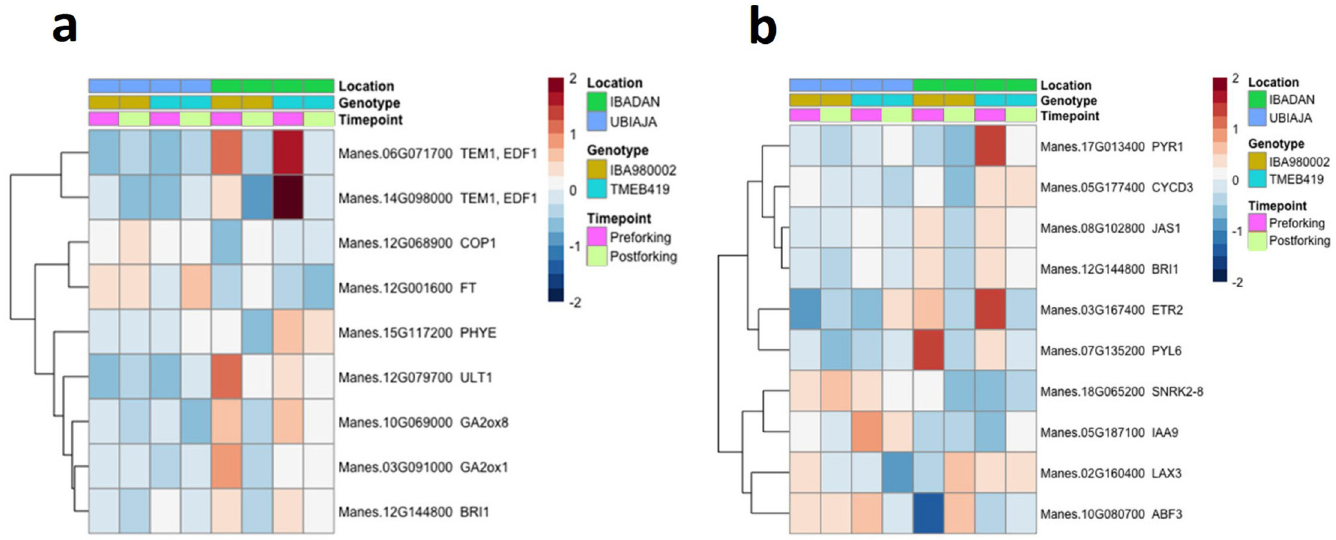
Fig 9. Flowering time and hormone signaling genes differentially expressed in leaves of two genotypes at two timepoints in field locations of Ubiaja and Ibadan. The heat map shows relative expression (log 2 scale) across location (Ubiaja vs Ibadan), genotype (‘0002 vs ‘419), and timepoint of development (preflowering and postflowering). a ) Flowering time genes; b ) Hormone signaling genes. Each gene is identified by its Manihot esculenta number (Manes) and its closest Arabidopsis homolog. Legend in header indicates color coding of variables. The indicated cassava homolog of Arabidopsis FT , Manes.12G001600, has been named MeFT1 [11].